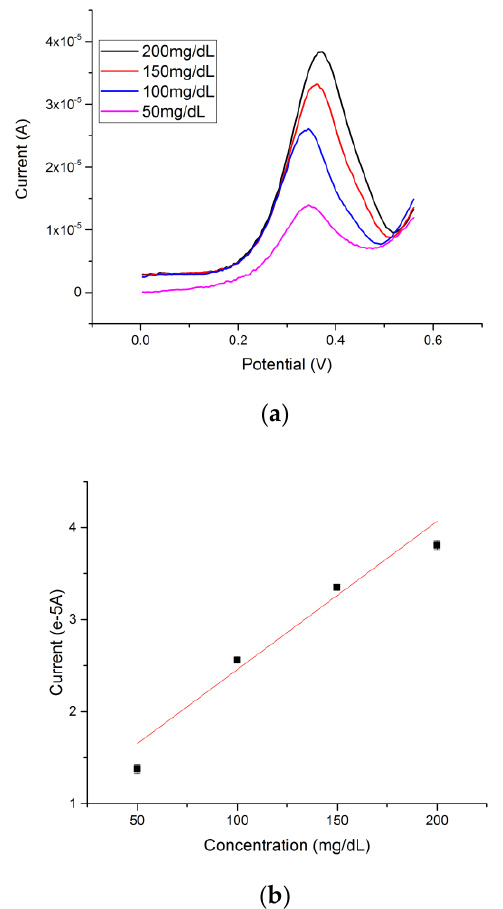
Figure 7. ( a ) Differential pulse voltammetry measurement of glucose concentrations ranging from 50 mg/dL to 200 mg/dL in undulated human serum; ( b ) Calibration linear relationship of DPV current outputs and concentrations of glucose.